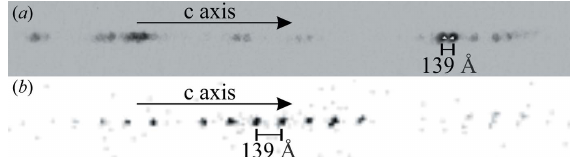
Figure 4 Single-crystal XRD frames of the (58) 3 hexaferrite collected using ( a ) the Rigaku diffractometer with a maximum detector distance of 137 mm and ( b ) the I19 synchrotron beamline with a 300 mm detector distance. Both frames illustrate the 139 A˚ primitive repeat of the (58) 3